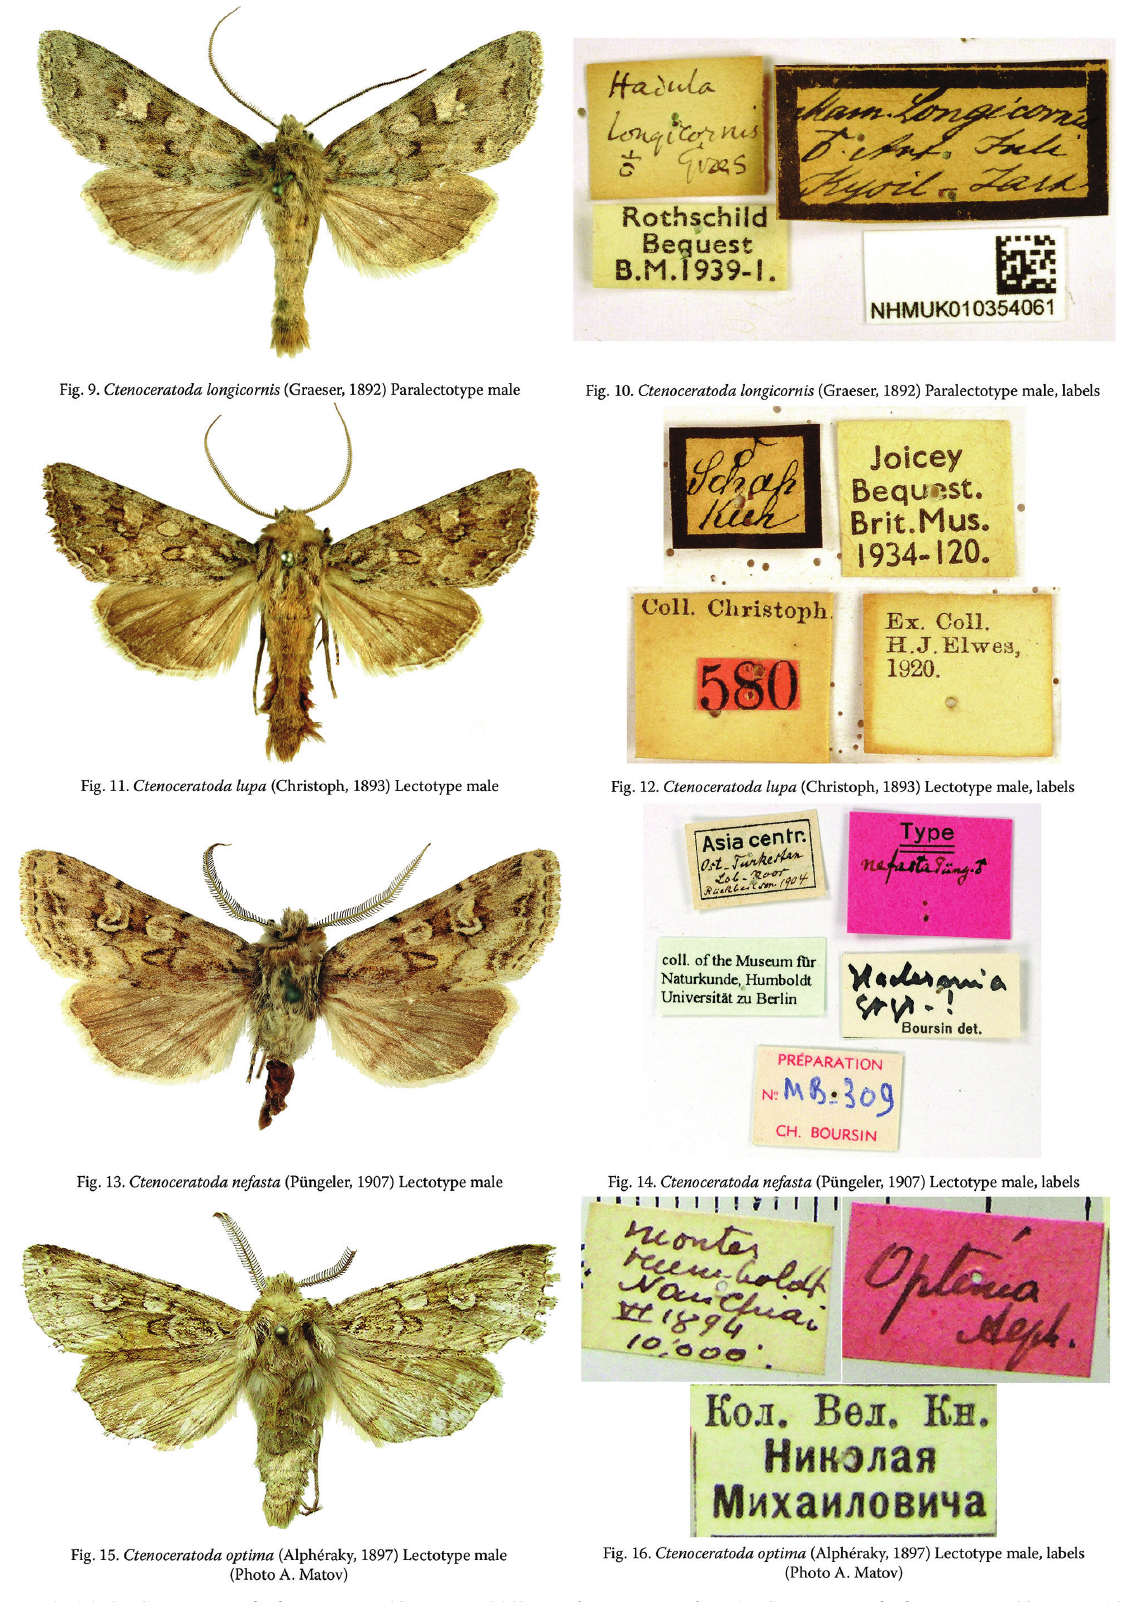
Figure 9–16. 9. Ctenoceratoda longicornis (Graeser, 1892) Paralectotype male. 10. Ctenoceratoda longicornis (Graeser, 1892) Paralectotype male, labels. 11. Ctenoceratoda lupa (Christoph, 1893) Lectotype male. 12. Ctenoceratoda lupa (Christoph, 1893) Lectotype male, labels. 13. Ctenoceratoda nefasta (Püngeler, 1907) Lectotype male. 14. Ctenoceratoda nefasta (Püngeler, 1907) Lectotype male, labels. 15. Ctenoceratoda optima (Alphéraky, 1897) Lectotype male. 16. Ctenoceratoda optima (Alphéraky, 1897) Lectotype male,